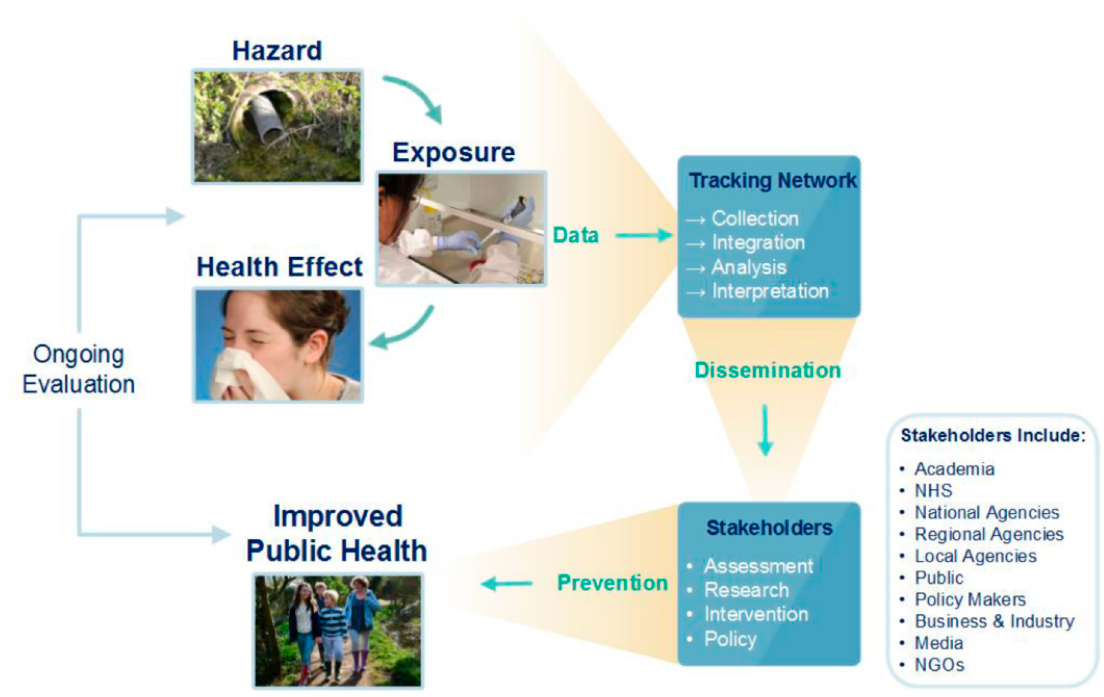
Figure 1. Environmental Public Health Tracking Components [17].